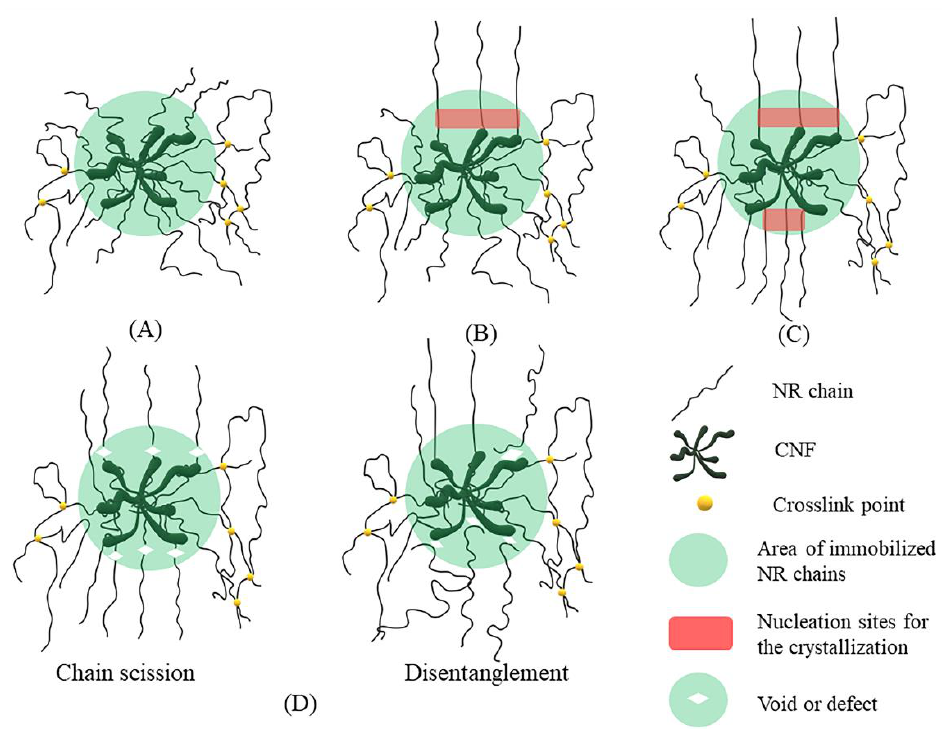
Figure 10. Proposed model for strain-induced crystallization mechanism of CNF/NR nanocomposite at ( A ) 0% strain ( B ) about 150% strain ( C ) about 200% strain and ( D ) over 200% strain.